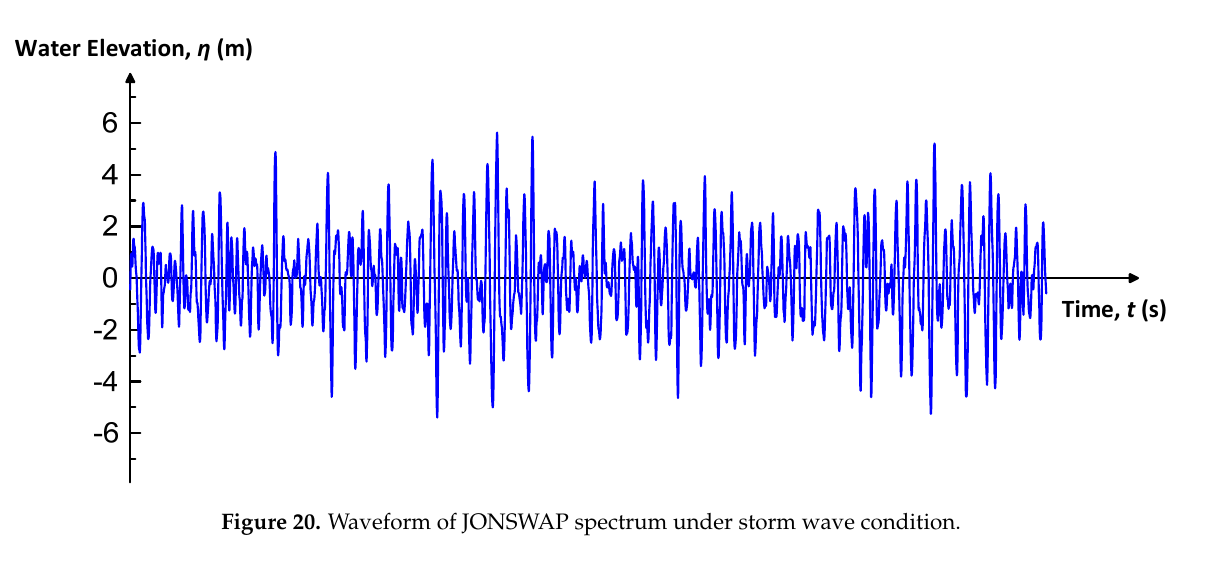
Figure 19. Historical typhoon tracks around Taiwan from 1897–2017.